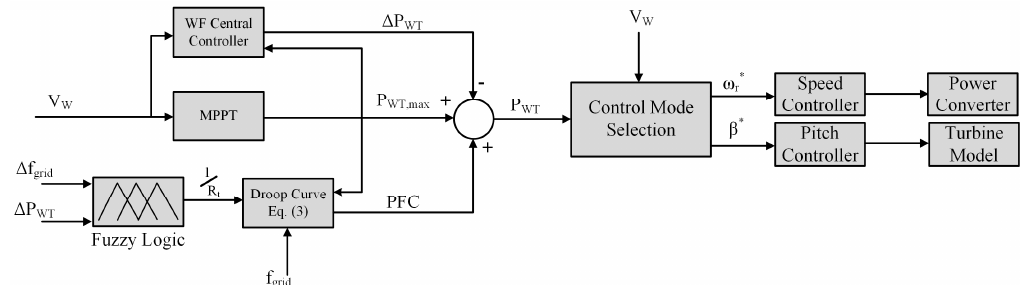
Figure 2. The implementation of fuzzy logic within the active power controller.